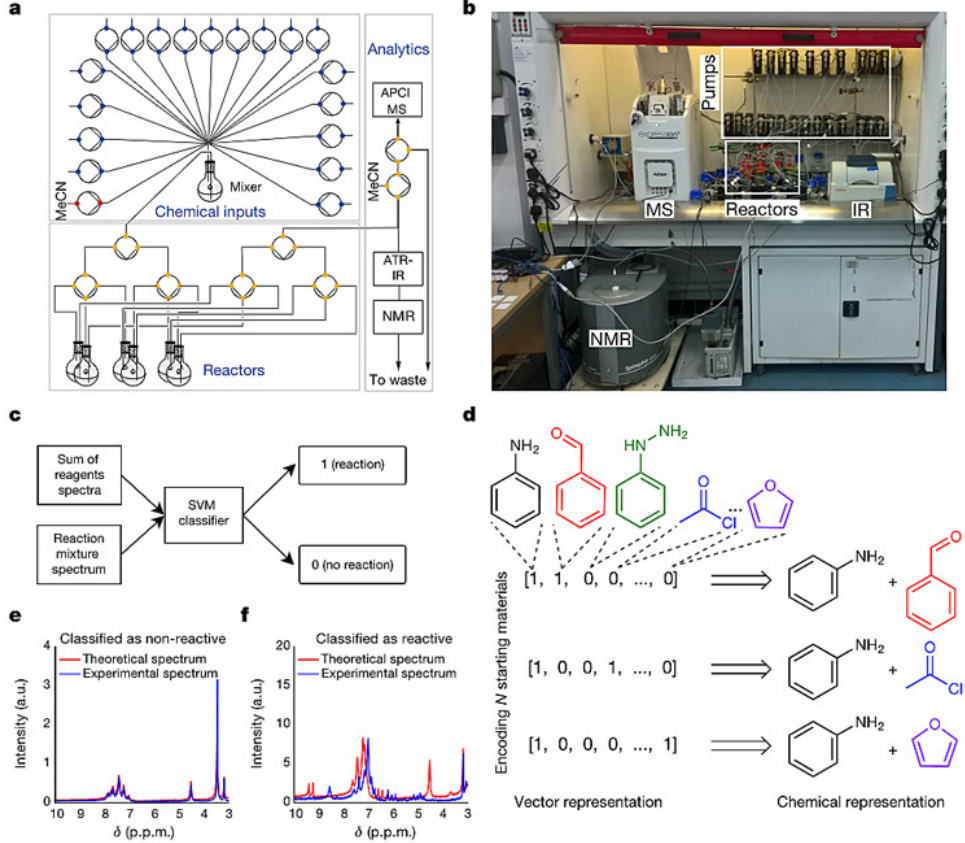
Figure 7. Synthetic robotic system with machine learning capabilities: ( a – f ). Reprinted with permission from ref. [55]. Copyright 2018, Macmillan Publisher Ltd., part of Springer Nature.